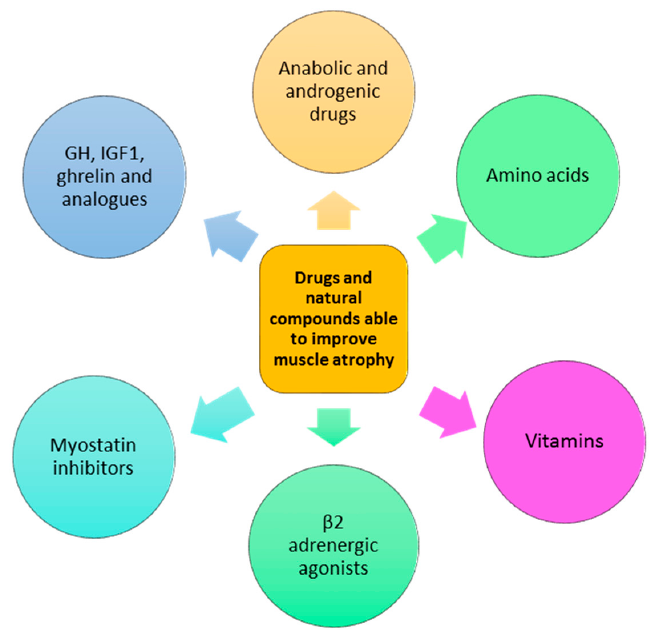
Figure 5. Drugs and natural compounds able to improve muscle atrophy.